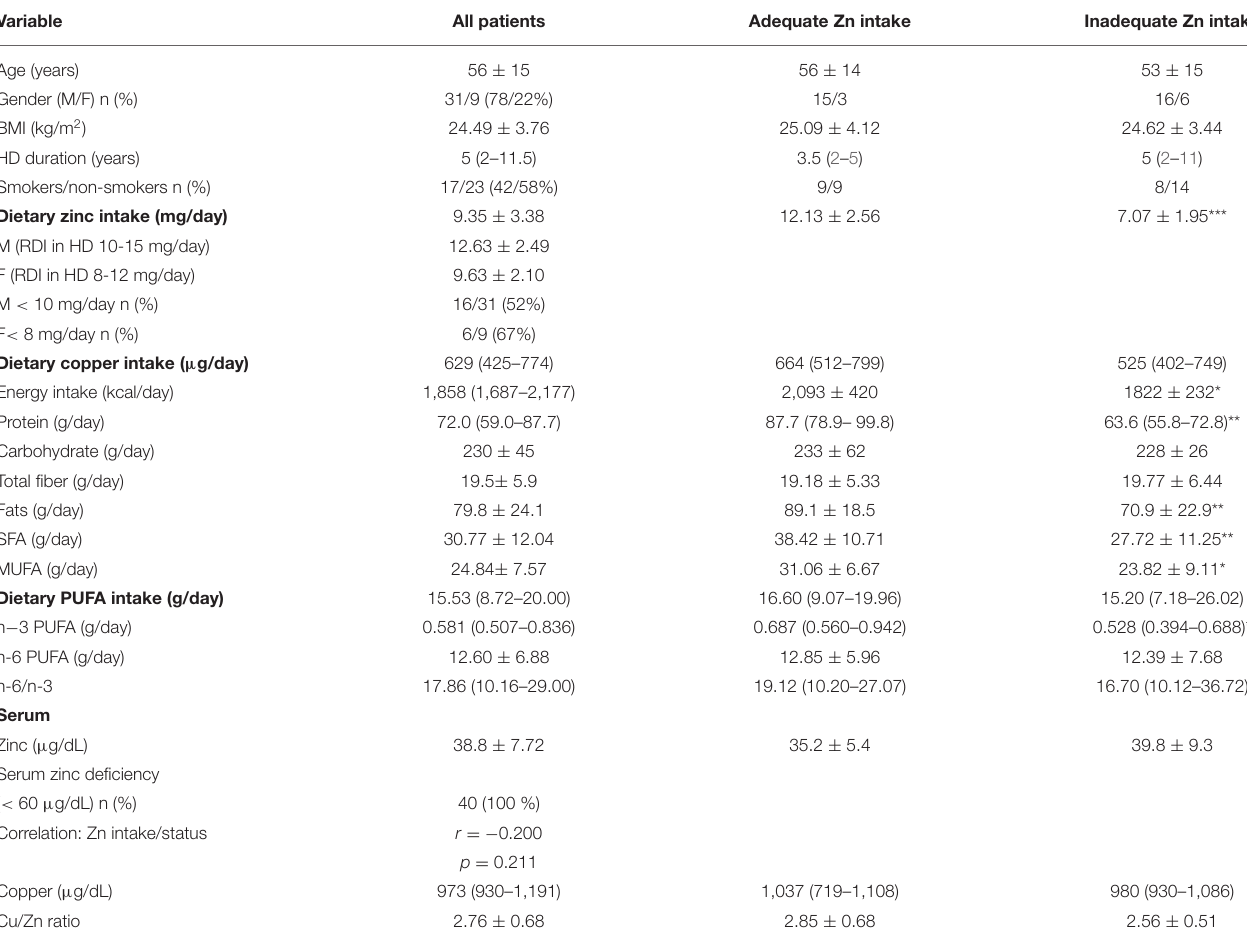
TABLE 1 | Demographic characteristic, dietary intake data, zinc and copper status in hemodialysis patients. Variable All patients